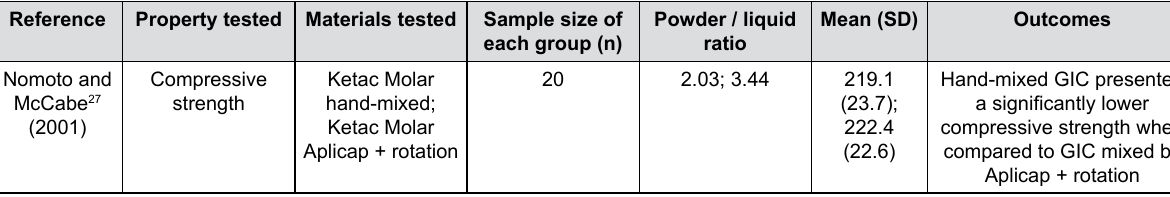
Figure 4- Characteristics of the study included in the review according to the property tested